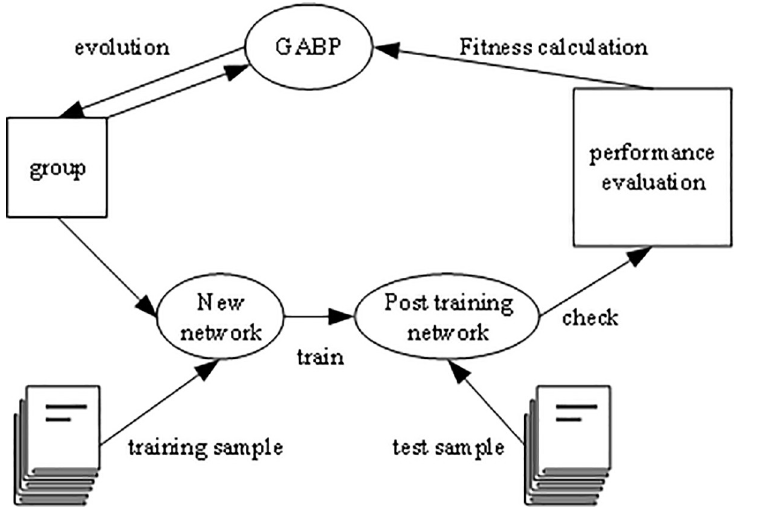
Fig 6. Training flow of GABP